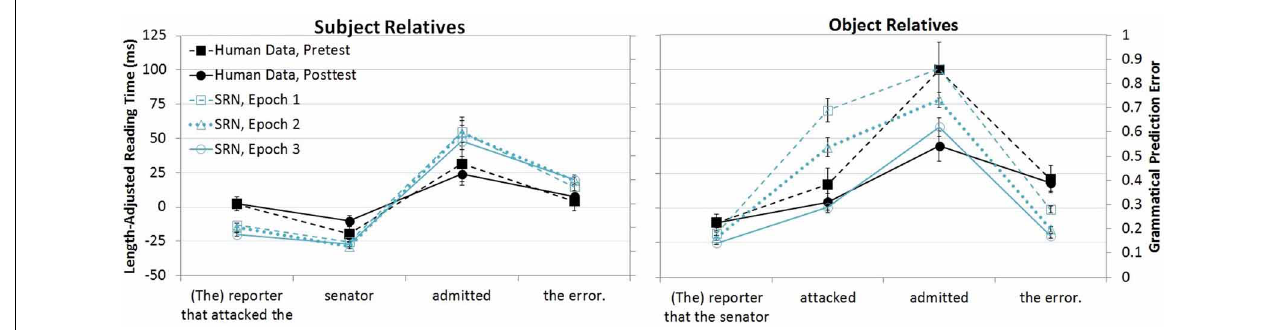
FIGURE 1 | Comparison of SRN performance in MacDonald and Christiansen (2002) and human reading times in Wells et al.